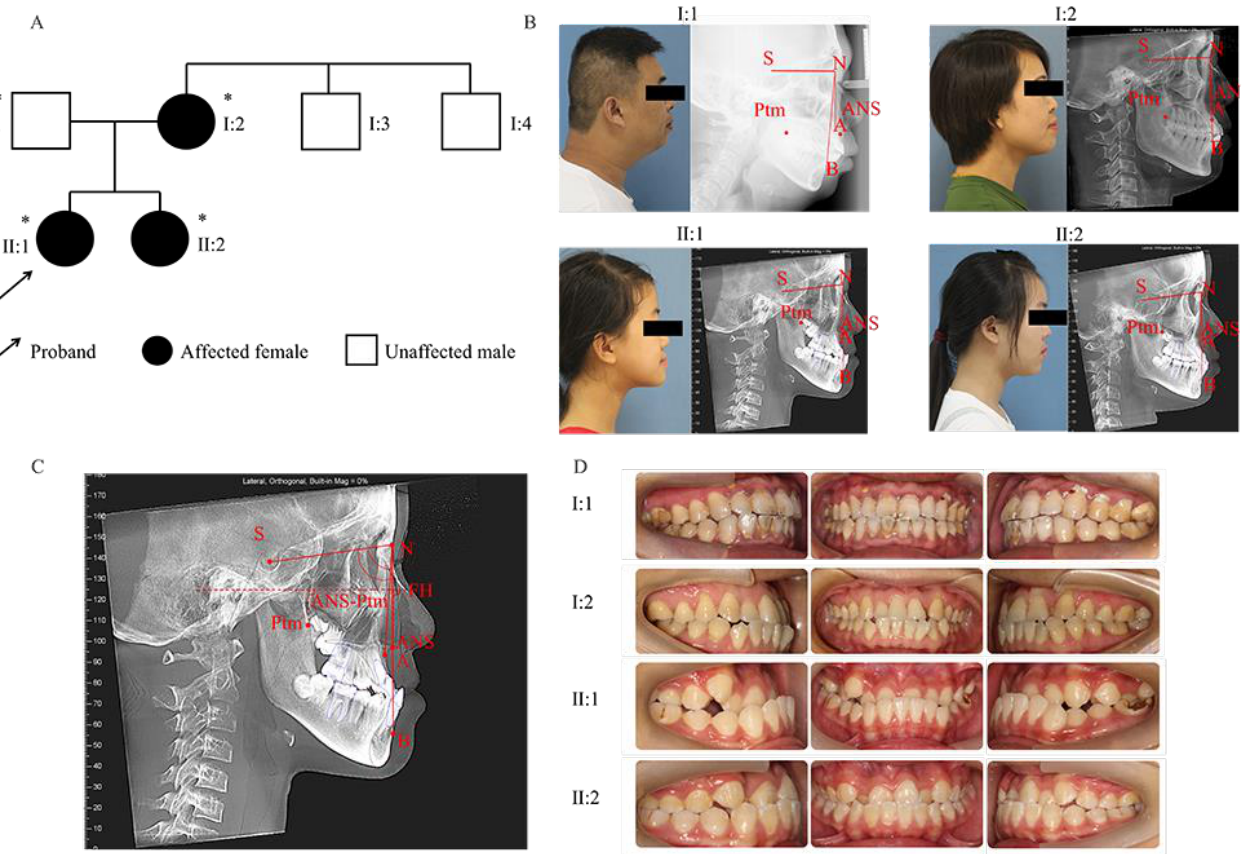
Figure 1. Pedigree and characterization of the skeletal Class III malocclusion. ( A ) Pedigree of the family. Asterisks represent participating family members. The proband (II:1) is a 12-year-old girl with skeletal Class III malocclusion. The arrow indicates the proband. ( B ) Profiles and lateral cephalograms. ( C ) Cephalometric landmark points. FH: Frankfort horizontal plane; S: sella; N: nasion; A: subspinale; B: supramental, Ptm: pterygomaxillary fissure; ANS: anterior nasal spine. ( D ) Intraoral views of